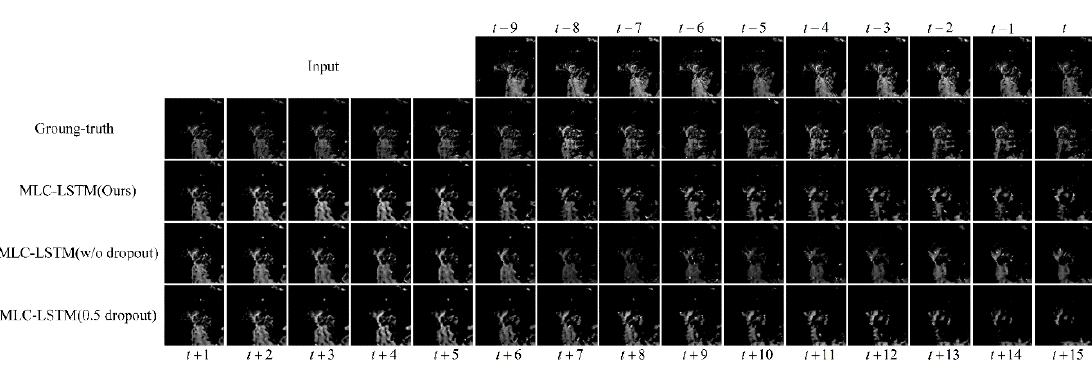
Table 3. Quantitative evaluation results of three models on six metrics. The mean value of six metrics of all 15 extrapolation steps is reported. The figures with bold-face indicate the best while the figures with underline indicate the second.